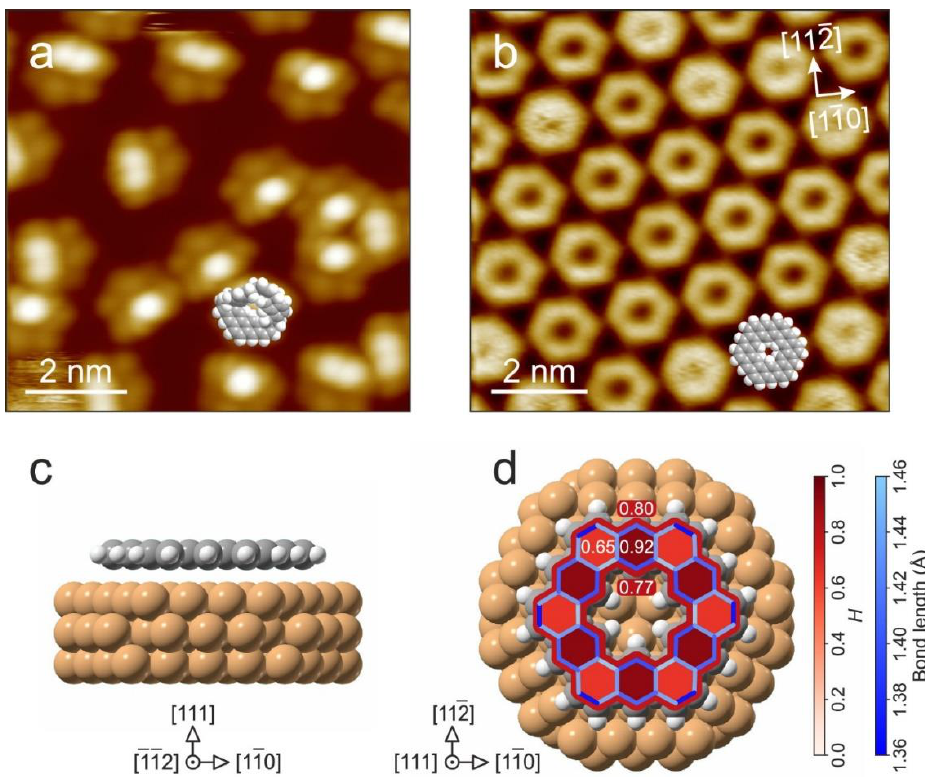
Figure 6. Structural information from STM and DFT: STM micrographs of the ( a ) precursor ( 1 ) and ( b ) kekulene ( 2 ) on Cu(111), measured at 100 K. Space-filling molecular models are added to illustrate nonplanar and planar molecular conformations of 1 and 2 , respectively. ( c , d ) Side and top views, respectively, of the relaxed adsorption geometry of kekulene/Cu(111) as obtained by DFT. HOMA values H and the bond lengths of adsorbed kekulene are color coded in red and blue, respectively. Reproduced from Ref. [56]; this work is licensed under the Creative Commons Attribution 4.0 International License (http://creativecommons.org/licenses/by/4.0/).